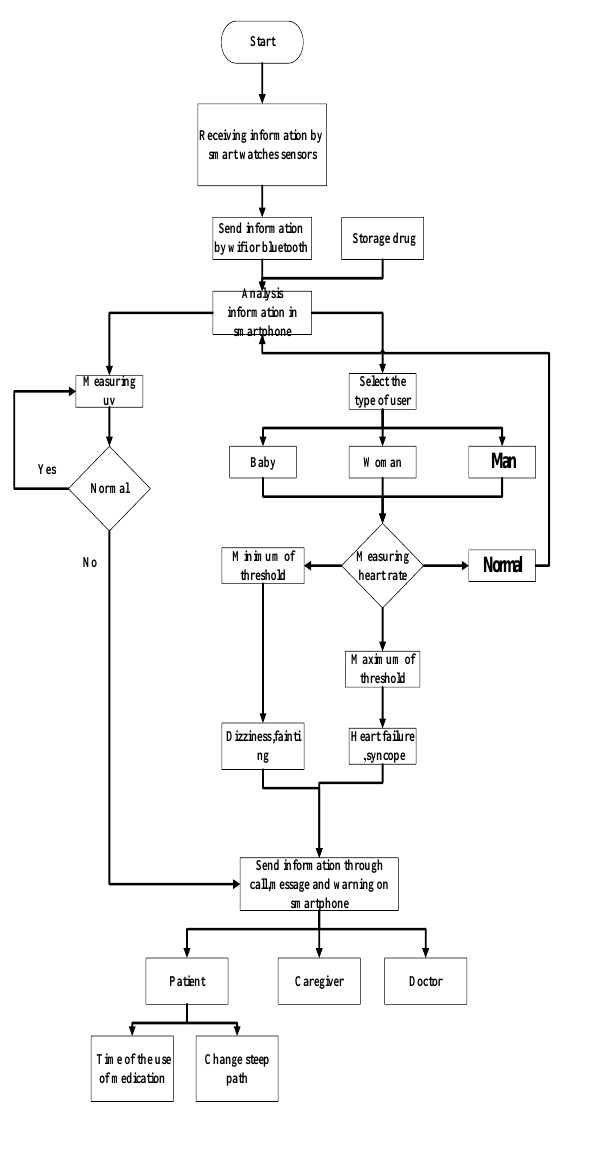
Figure 4 indicates the class diagram of the designed system in which the main components of the system such as smartphone, smart-watch, patient, physician, and functions and sensors used in it have been